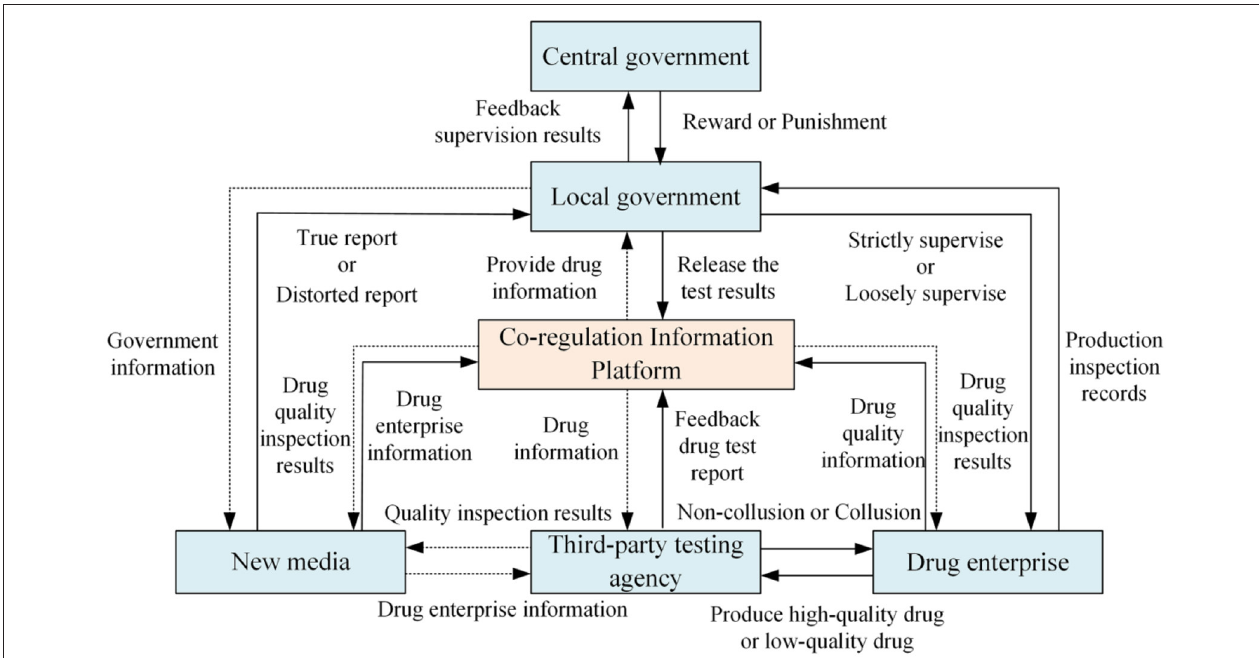
FIGURE 1 | Four-party evolutionary game structure relationship. Figure is the structural relationship diagram that shows the relationship among local government, drug enterprises, third-party testing agencies and new media based on the co-regulation information platform under the reward and punishment of the central